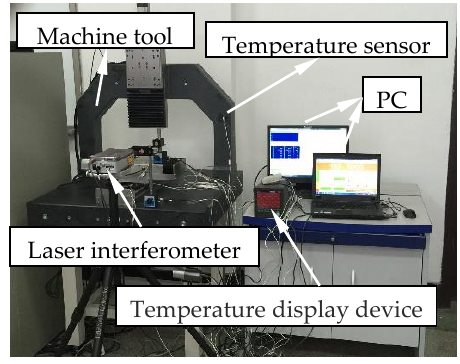
Figure 5. Measurement